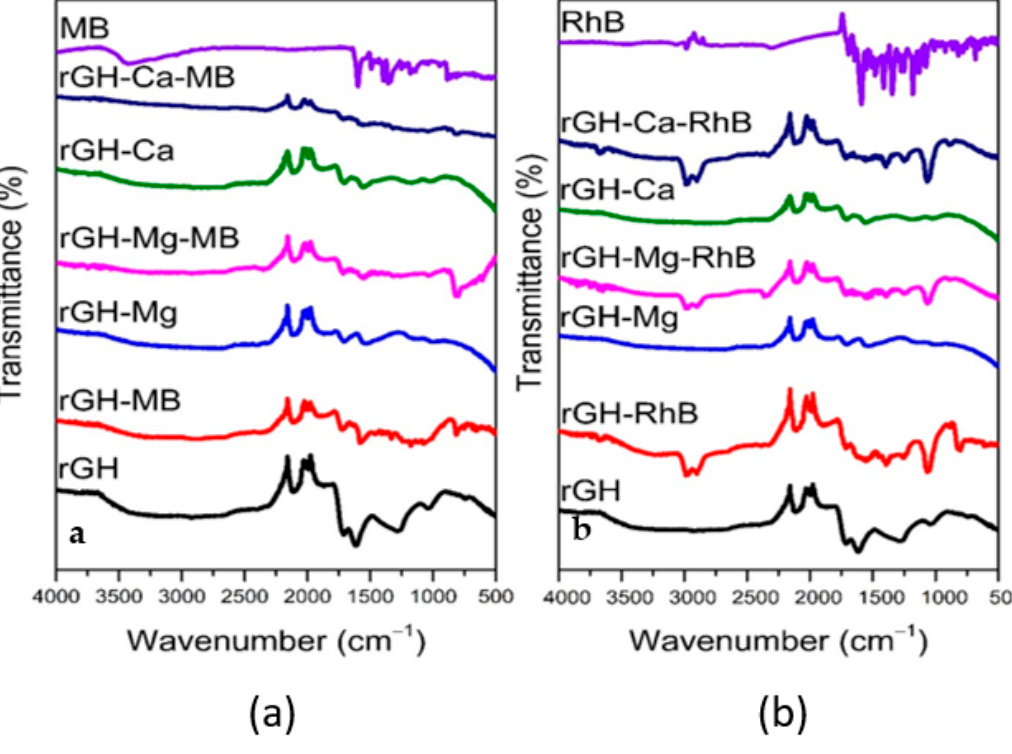
Figure 7. FTIR of freeze-dried rGHs before and after adsorption with ( a ) MB and ( b ) RhB.